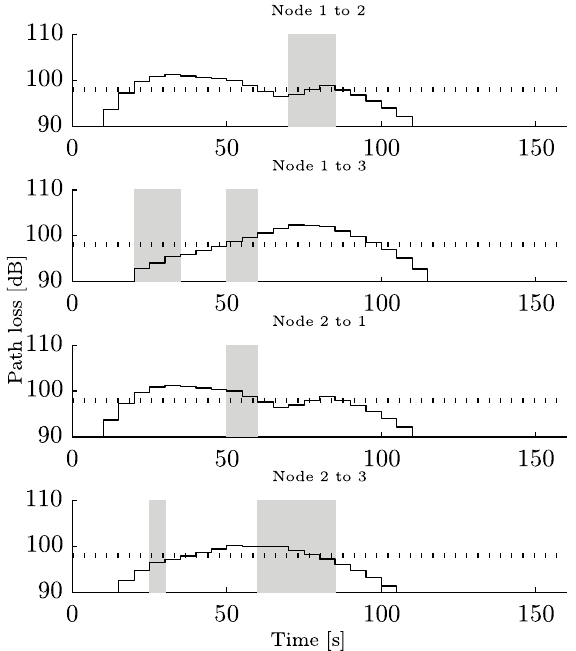
Figure 8: Scenario 0: The calculated path loss us- ing SPLAT! (solid black), maximum allowed path loss for communication 98 dB (dashed black) and time steps when high band- width communication is required (shaded grey area). Notice that, the communication path loss requirement of 98 dB is violated at several